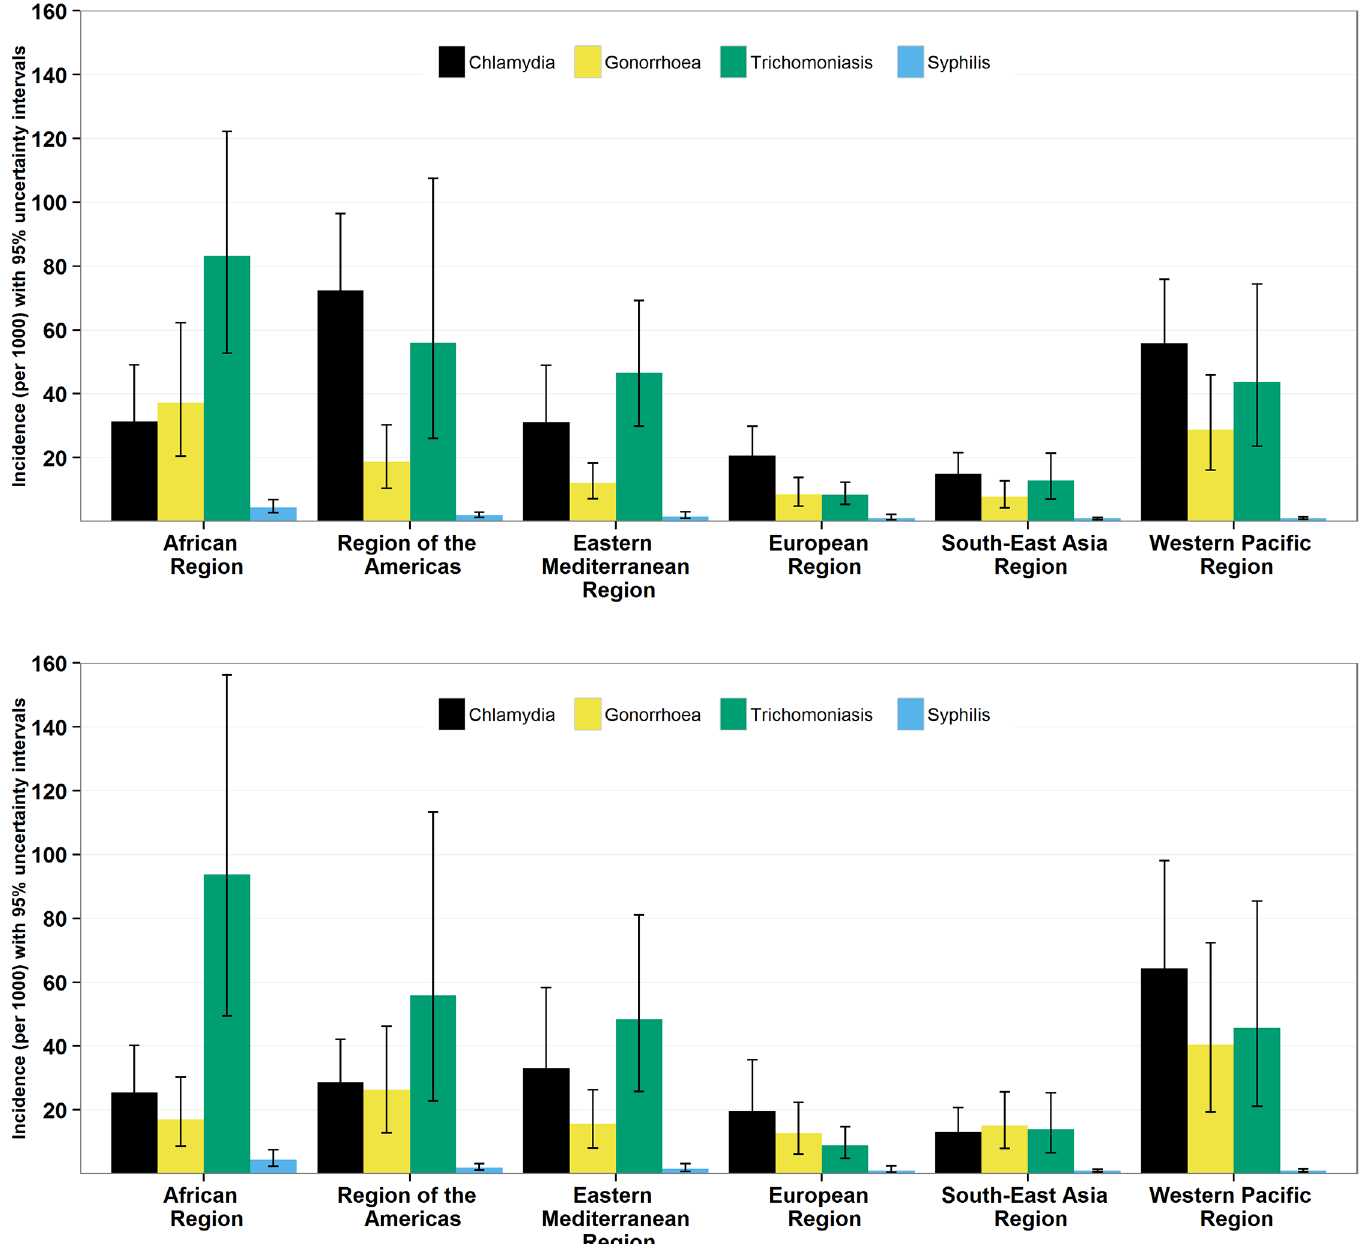
Fig 3. Incidence (and 95% UI) of chlamydia, gonorrhoea, trichomoniasis, and syphilis in women and men aged 15 – 49 years by WHO region, based on 2005 to 2012